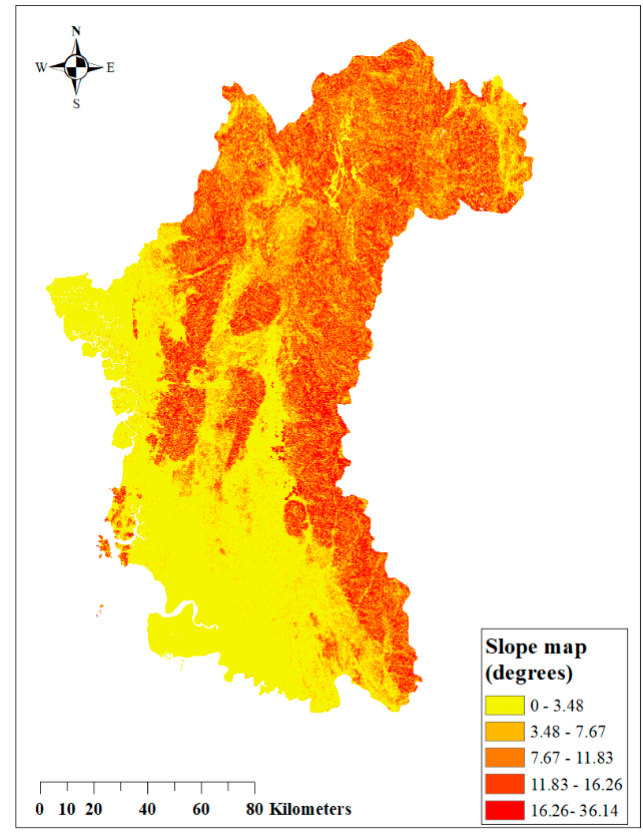
Figure 3. Slope map of the study area.